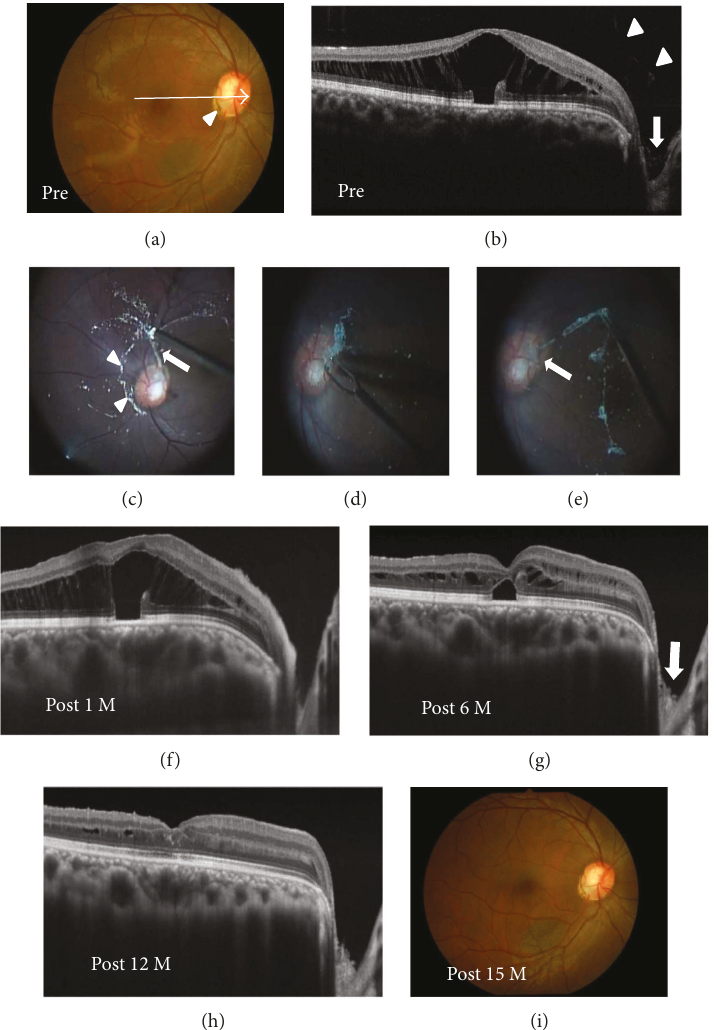
Figure 1: Photographs of the right eye in a 20-year-old optic disc pit (ODP) maculopathy patient without posterior vitreous detachment (PVD) (case 1). (a, b) Findings before surgery. Fundus photograph showed an ODP (a, arrowhead) and retinal elevation at the macular area (a). An arrow indicates an enhanced depth imaging optical coherence tomography (EDI-OCT) scan for the images shown in Figure 1. An EDI-OCT image revealed retinal schisis extending from the optic disc to the macula with foveal retinal detachment (b). The posterior hyaloid membrane (b, arrowheads) was attached toward the membrane that was present on the ODP (b, arrow). (c – e) Findings during pars plana vitrectomy with epipapillary membrane removal. When PVD was intentionally made, most of the hyaloid membrane was detached from the optic disc (c, arrowheads). However, a part of the membrane connected with the glial tissue on the disc (c, arrow). After making a complete PVD, the membrane tissue that remained on the ODP was grasped using forceps (d). The glial tissue was fi rmly attached, penetrating the ODP (e, arrow). (f – i) Postoperative OCT images. The retinal schisis gradually was reduced (f, g) and was resolved with foveal attachment 12 months after the surgery (h). The membrane tissue on the disc was also removed (g, arrow). Fundus photograph at 15 months after surgery shows the resolution of the retinal schisis